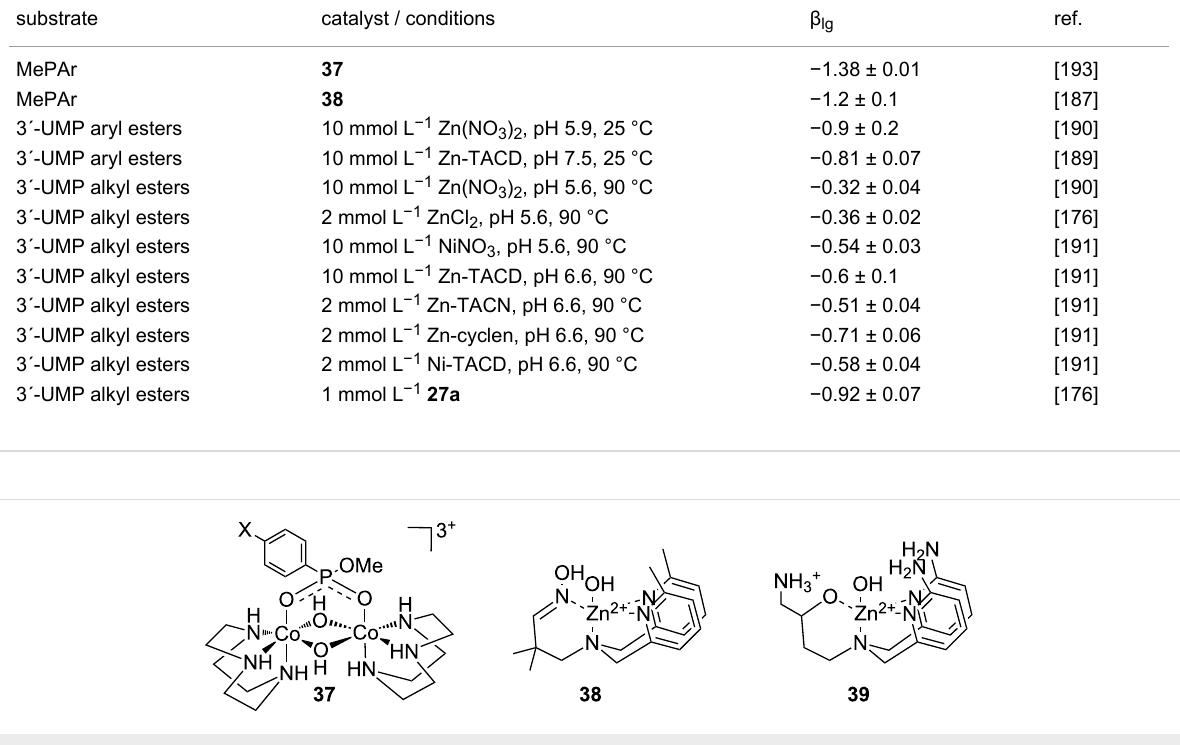
Table 5: β lg values for cleavage reactions of phosphodiesters promoted by metal ion catalysts. substrate catalyst / conditions